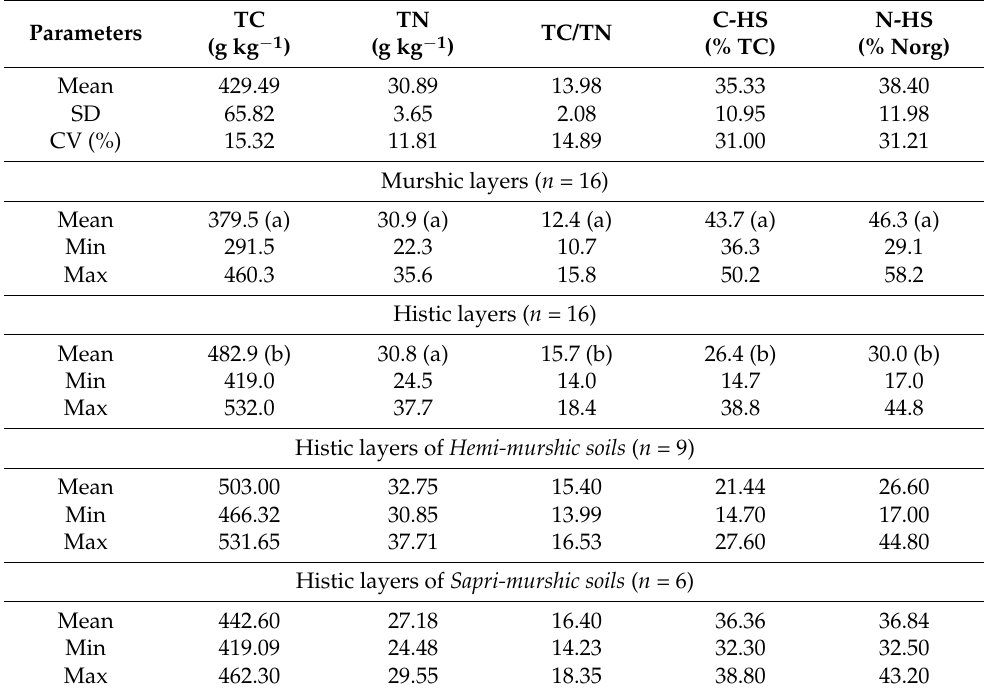
Table 5. Values of descriptive statistics of carbon and nitrogen contents, the TC/TN rate, and the carbon and nitrogen shares in humic